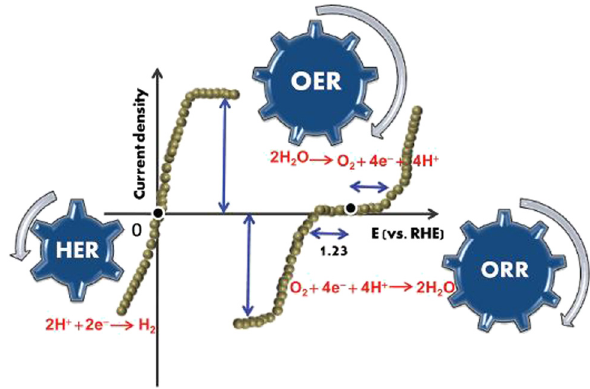
Figure 1: Schematic illustration of electrochemical reactions associated with water splitting. Reprinted from ref. [ 22 ] ; copyright ( 2018 ) , Royal Society of